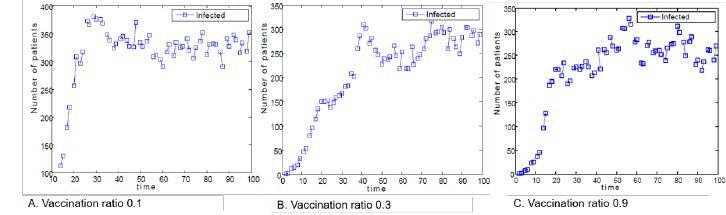
Fig. 3 Impact of education ratio on communicators.